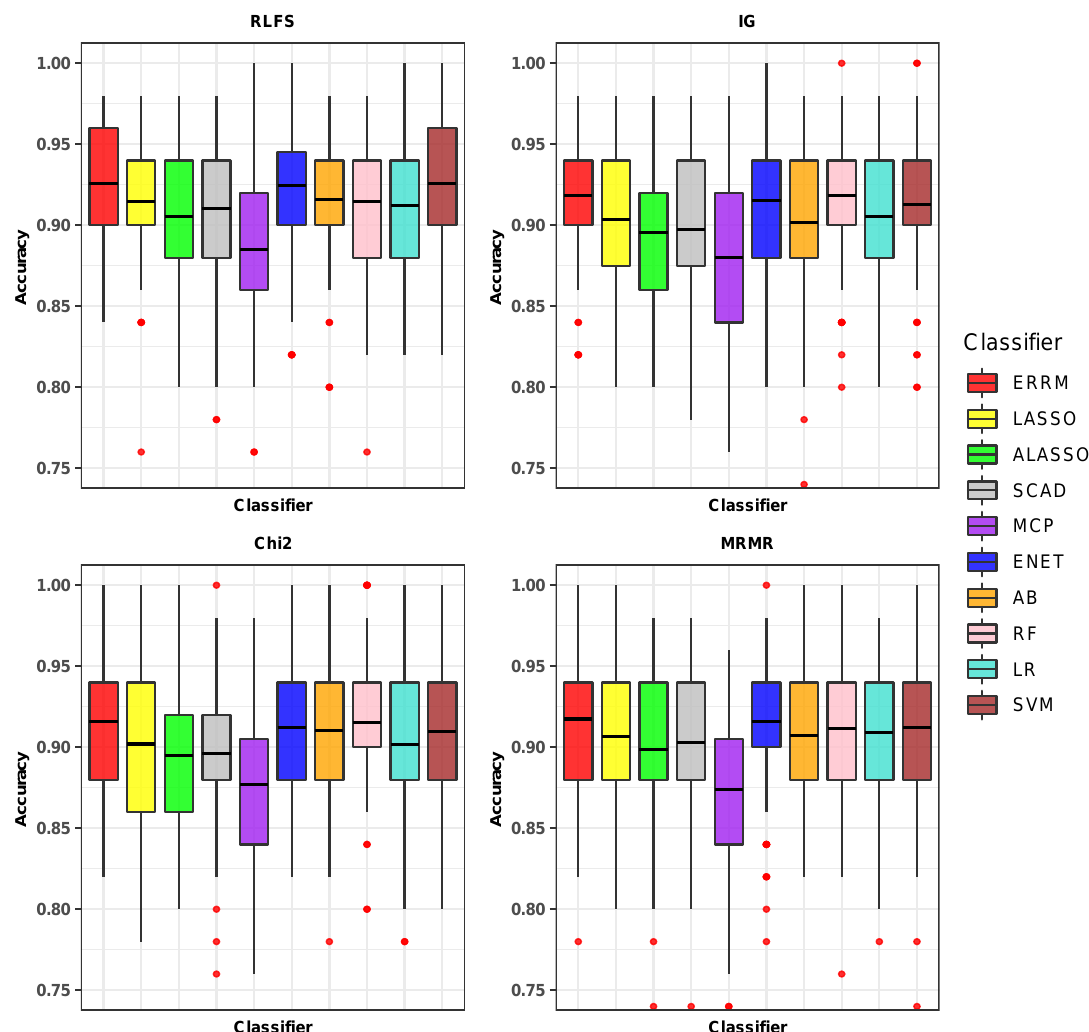
Figure 4. Boxplot showing the accuracies of classifiers with FS methods when correlation =